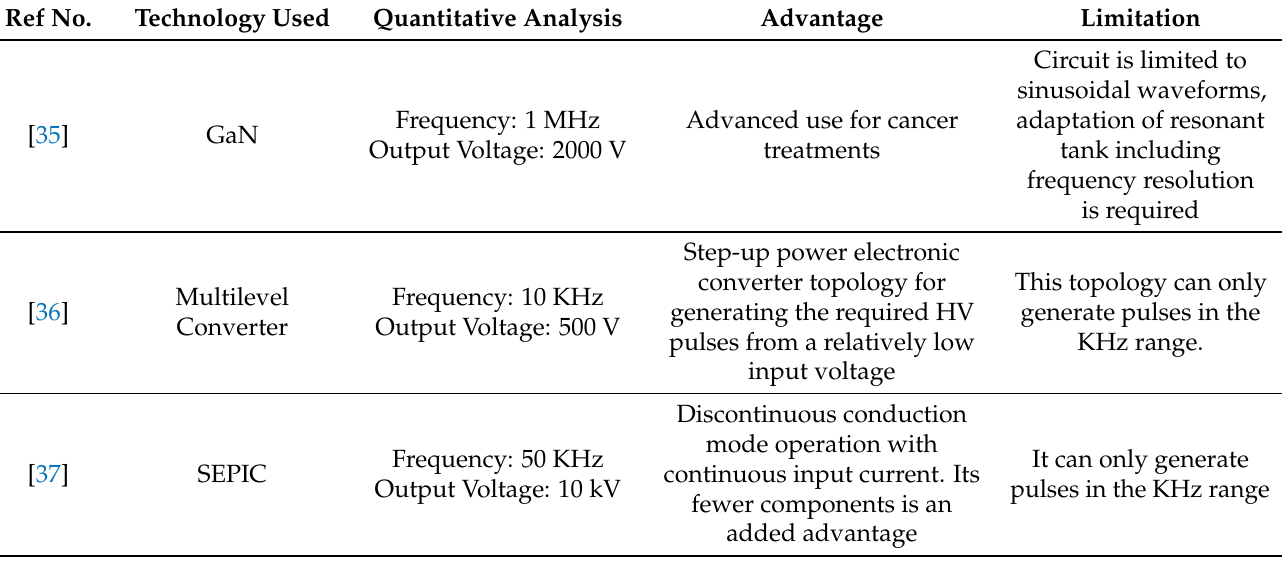
Table 1. Comparison of the present state-of-the-art for electroporator